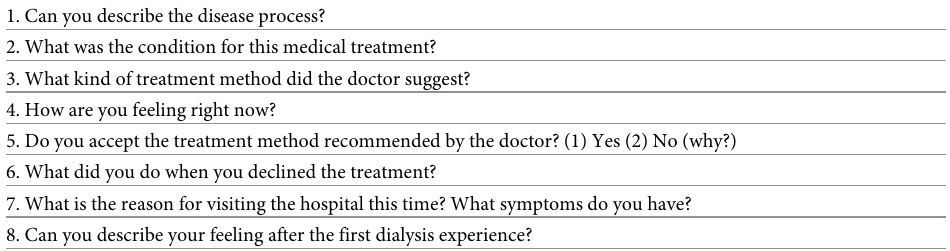
Table 2. Semi-structured interview guide used for the in-depth